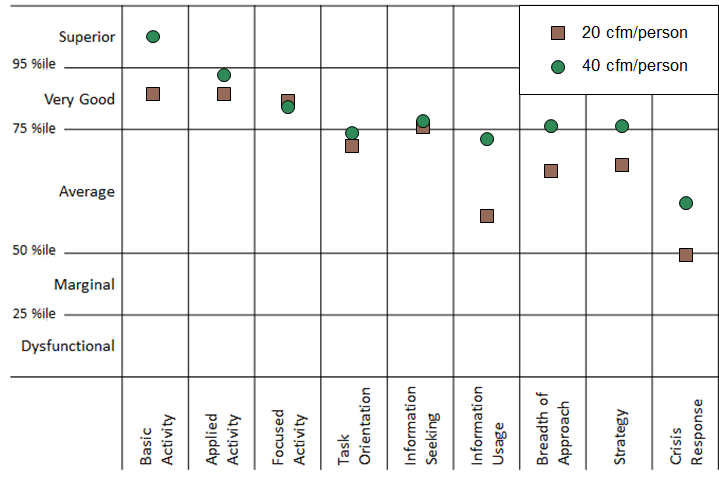
Figure 1. Average cognitive performance on the SMS tool of 24 participants in a green building at 20 and 40 cfm/person of outdoor air relative to normative data from ~70,000 people.